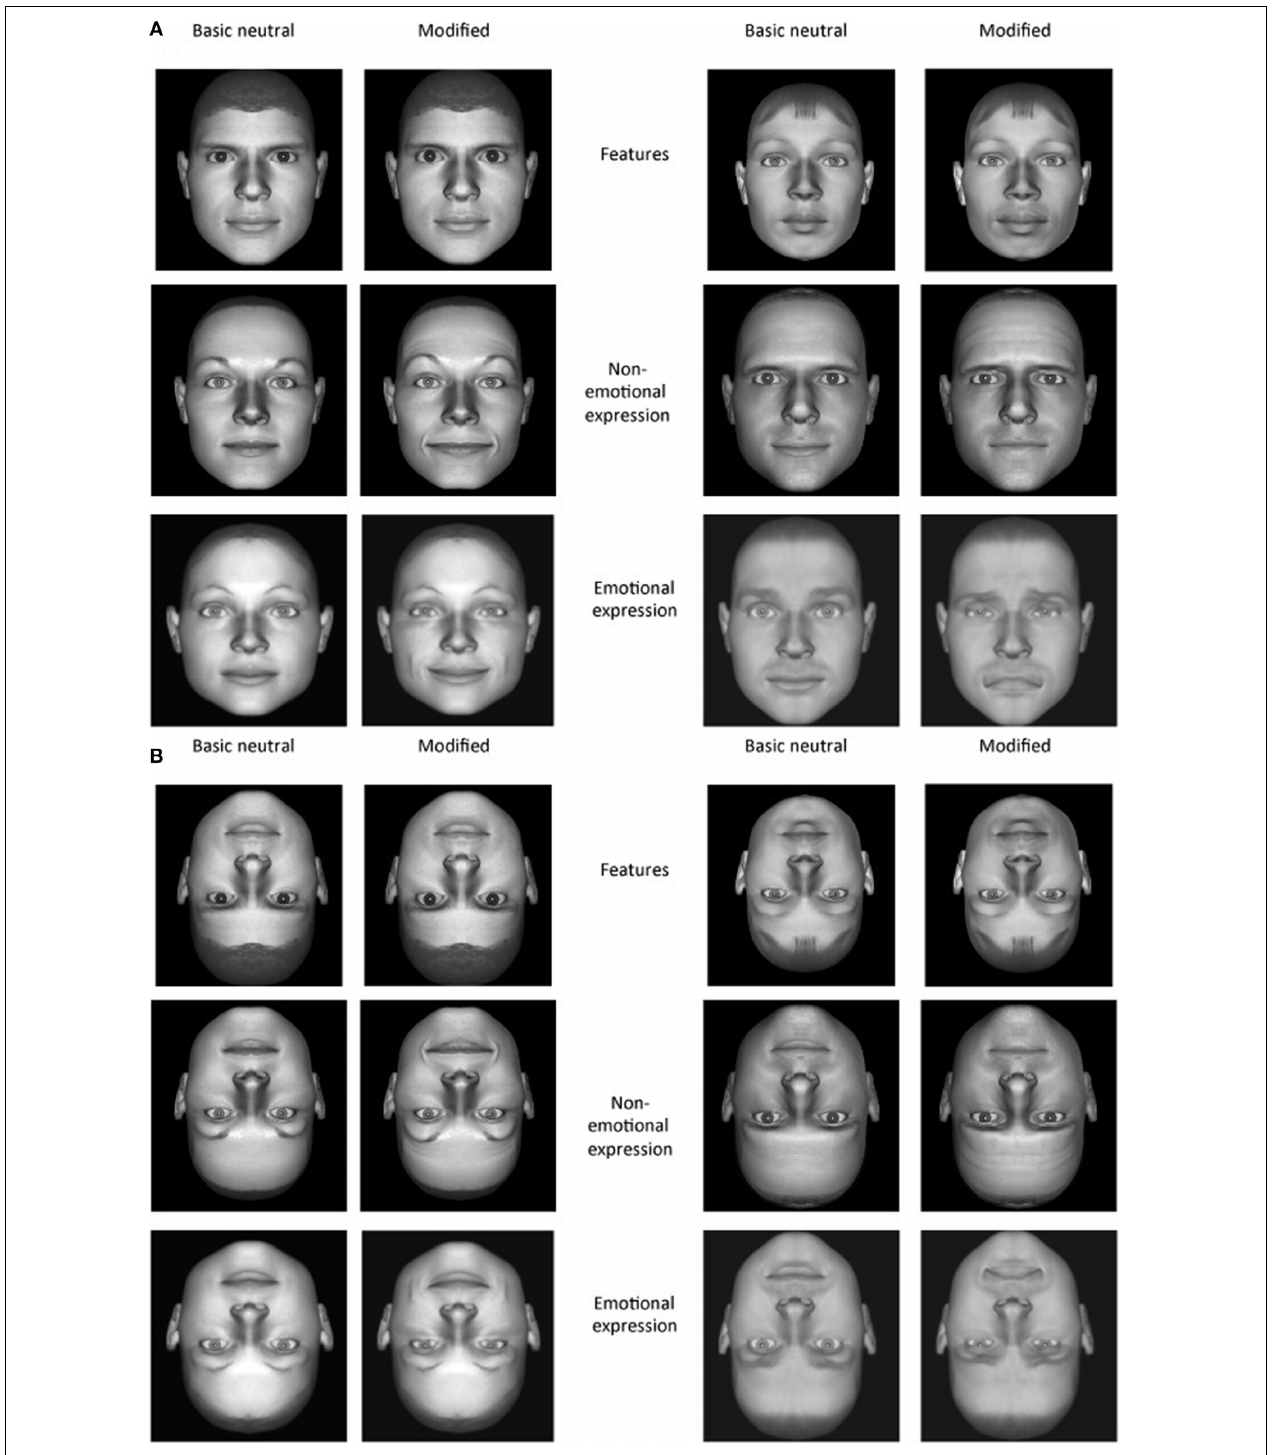
FIGURE 1 | (A) Examples of basic neutral faces (male and female) and their modified versions. The changes in features are depicted in the two upper rows. On the left enlarged eye size; on the right enlarged mouth size. The changes in non-emotional expressions are depicted in the middle rows. On the left the change occurred in the upper part of